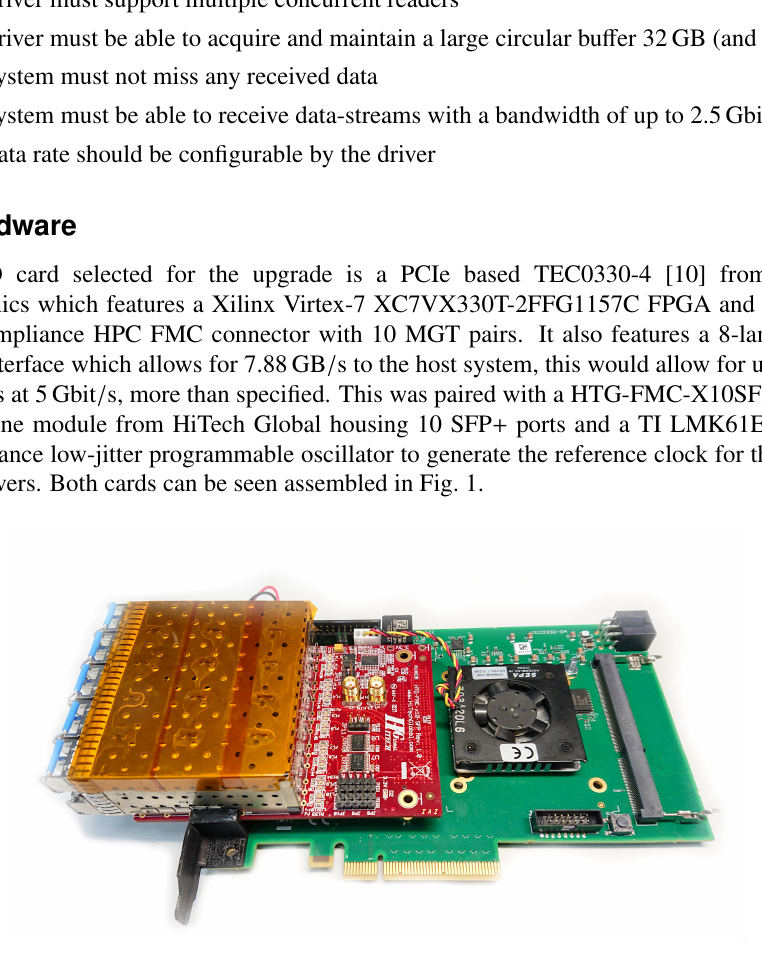
The server model chosen for the upgrade is the Gigabyte G481-HA0 [12], depicted